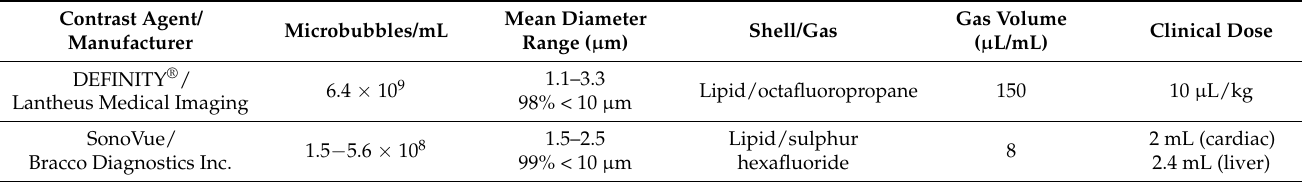
Table 2. Contrast agents and physical characteristics of reconstituted microbubbles (from manufac- turers’ literature).